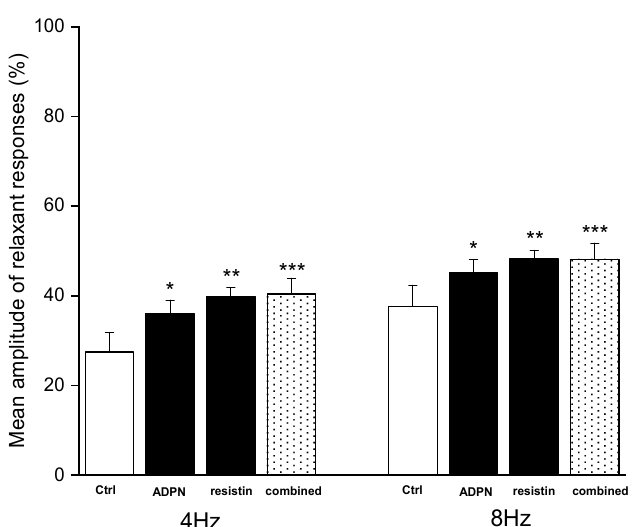
Figure 4. Lack of additional effects on the mean amplitude of the EFS-induced relaxant responses after the simultaneous inclusion of the two adipokines to the bath medium. Bar chart showing the significant increase in the mean amplitude of electrical field stimulation (EFS)-evoked relaxant responses at 4 and 8 Hz stimulation frequency evoked by adiponectin (ADPN, 20 nM), resistin (60 ng/mL) or the simultaneous inclusion of the two adipokines to the bath medium. Note the apparently more pronounced influence, although not statistically different, of resistin compared to ADPN and the lack of additional effects of the two adipokines when simultaneously added to the bath medium. Amplitude values refer to the maximum peaks obtained during the stimulation period and represent percentage decreases relative to the muscular tension induced by carbachol (CCh, 1 µ M), taken as 100%. All values are means ± SEM of 4/6 strips. * p < 0.05 vs. its own control (Ctrl); ** p < 0.05 vs. its own Ctrl and p > 0.05 vs. ADPN; *** p < 0.05 vs. its own Ctrl and p > 0.05 vs. ADPN or resistin (one-way ANOVA followed by Newman–Keuls post-test).